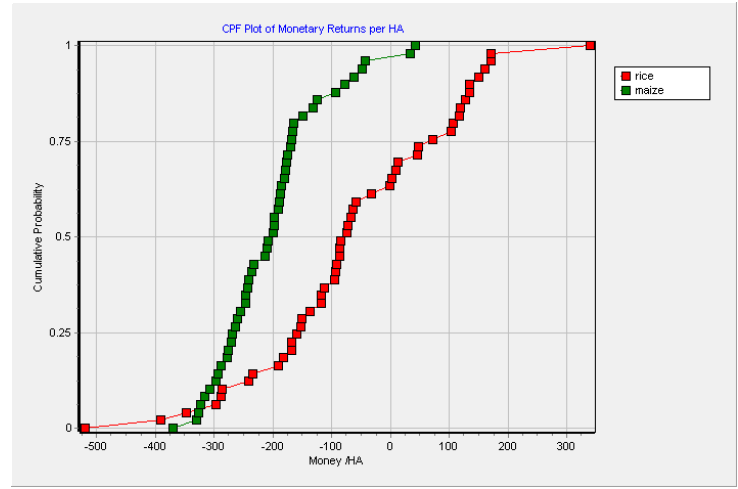
Figure 7. Cumulative probability distribution of rice and maize production in the future.